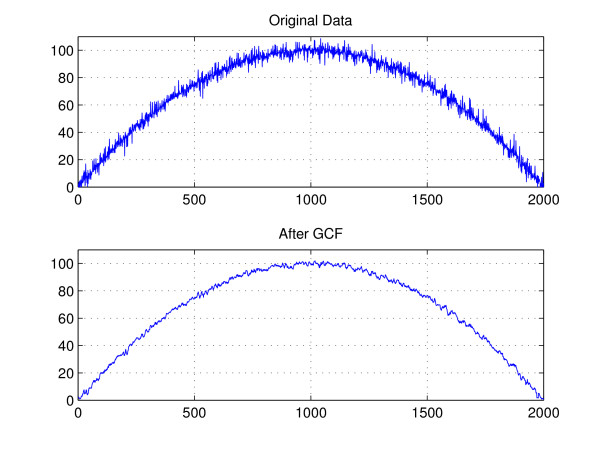
Plots for r [n] and [n]. Original data (r [n]) and after GCF ([n]).